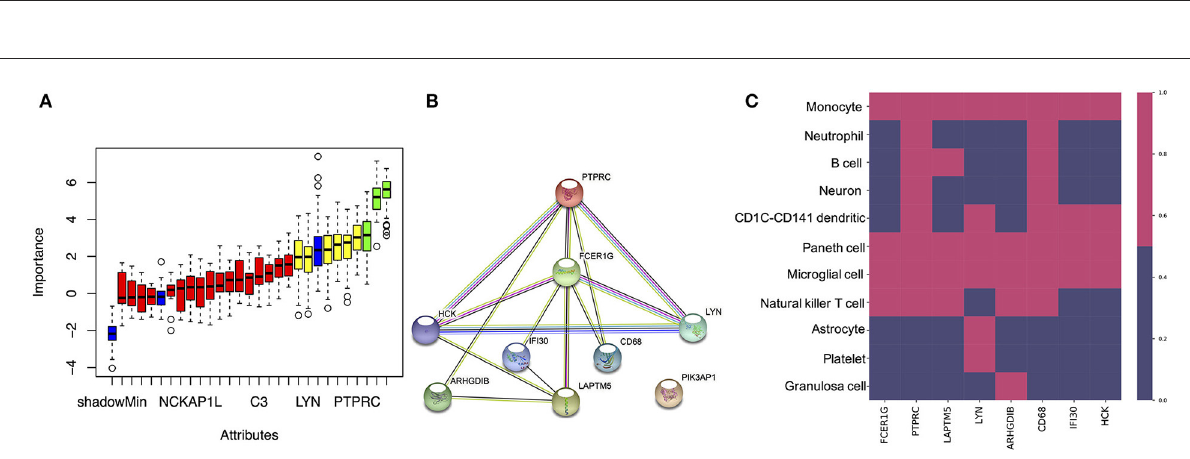
FIGURE5 Identifying the most important genes via RF and the cellular distribution of the important genes in the brain. (A) Random Forest algorithm result. The blue box plot corresponds to the minimum, average, and maximum Z scores of a color attribute. The red, yellow, and green boxes represent the Z scores of rejected, tentative, and confirmed genes, respectively. (B) The PPI network of important genes via String. (C) The heatmap shows the distribution of the selected genes in different cell types.